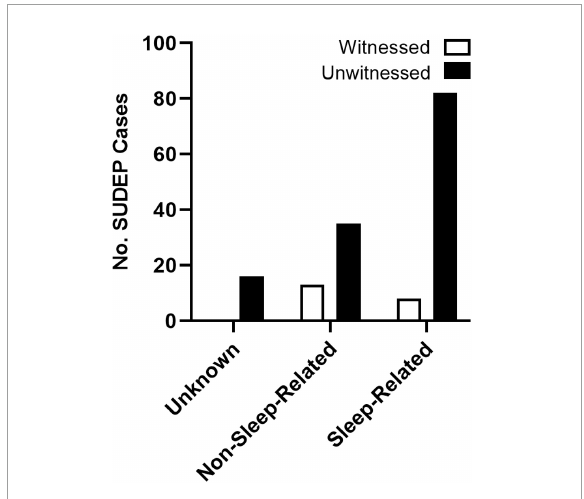
FIGURE3 Presumed state of wakefulness during SUDEP events. SUDEP events are often unwitnessed and are frequently associated with sleep. Unwitnessed sleep-related and non-sleep-related seizures were based on the circumstances surrounding death. Events were considered sleep-related if the victim was found in their bed or near their bed with evidence of a recent seizure. For events when victims were not found in the bedroom, SUDEP events were considered non-sleep-related. Events without location or other circumstances surrounding death were considered unknown. Redrawn with permission from John Wiley and Sons from Lamberts et al.